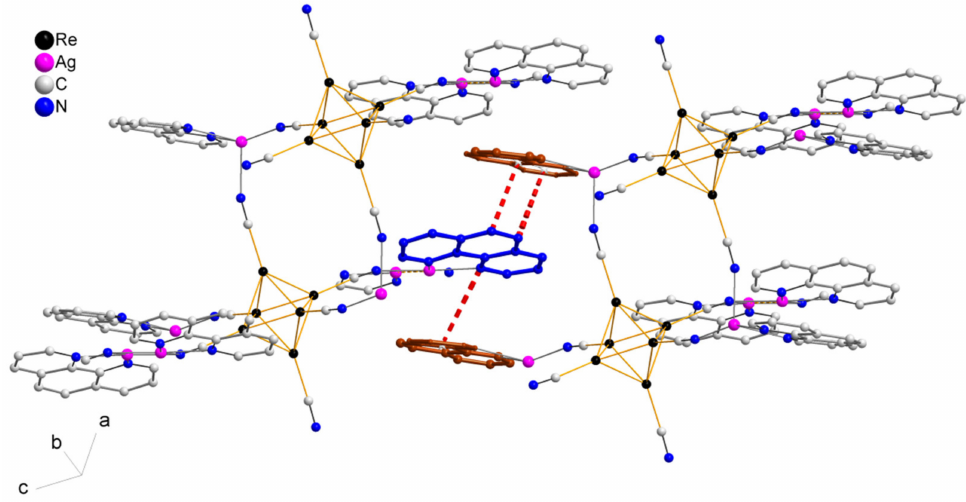
Figure 6. A scheme of CH . . . π interactions between phenanthroline aromatic